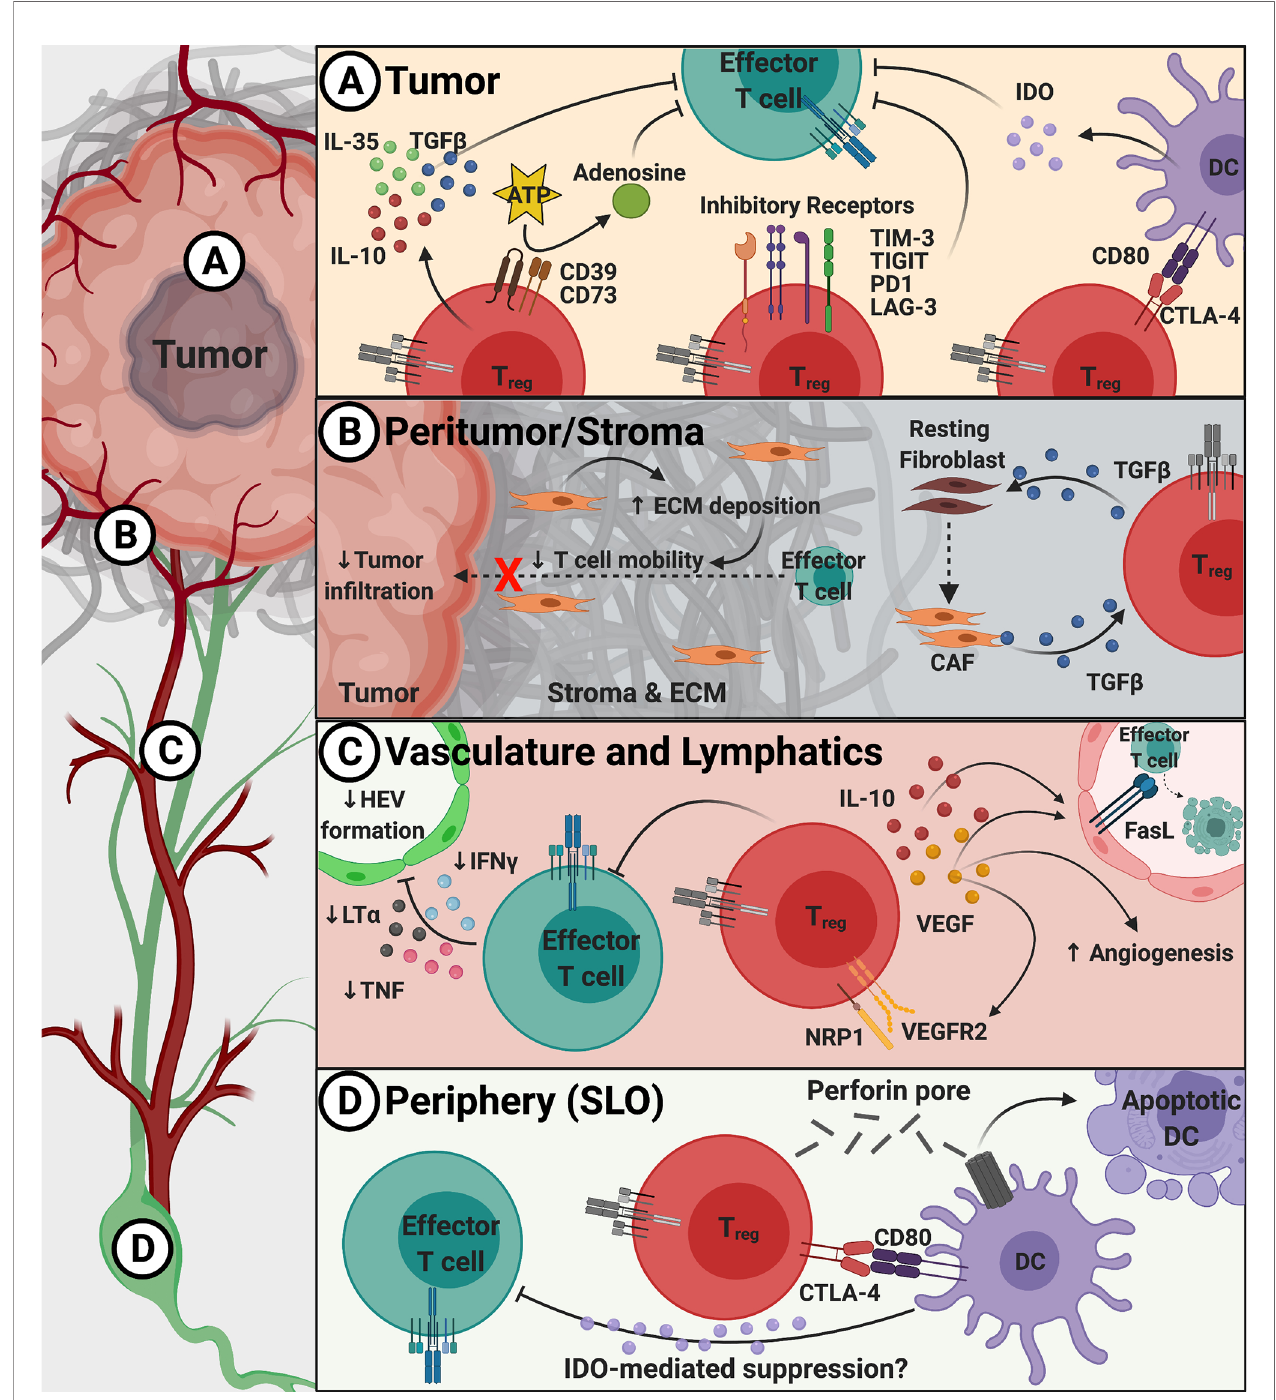
FIGURE 1 | Overview of suppressive mechanisms used by T regs to create barriers to immune in fi ltration into tumors. Panel (A) Within the TME, T regs utilize inhibitory receptors (TIM-3, TIGIT, PD1, and LAG-3), inhibitory cytokines (TGF b , IL-10, and IL-35), DC modulation (via CTLA-4 and LAG-3), and metabolic disruption (via CD39/ CD73) to suppress the anti-tumor T cell response. (B) T reg -derived TGF b induces cancer-associated fi broblast (CAF) development that increases extracellular matrix (ECM) production and deposition within the peritumoral space (stroma) to inhibit effector T cell migration. (C) T regs block entry of effector T cells through preventing proper cytokine signals that promote high endothelial venule (HEV) formation as well as production of inhibitory IL-10 and VEGF to promote dysregulated angiogenesis. (D) In the periphery and secondary lymphoid organs (SLO), T regs can modulate DC maturity and induce apoptosis to prevent proper effector T cell